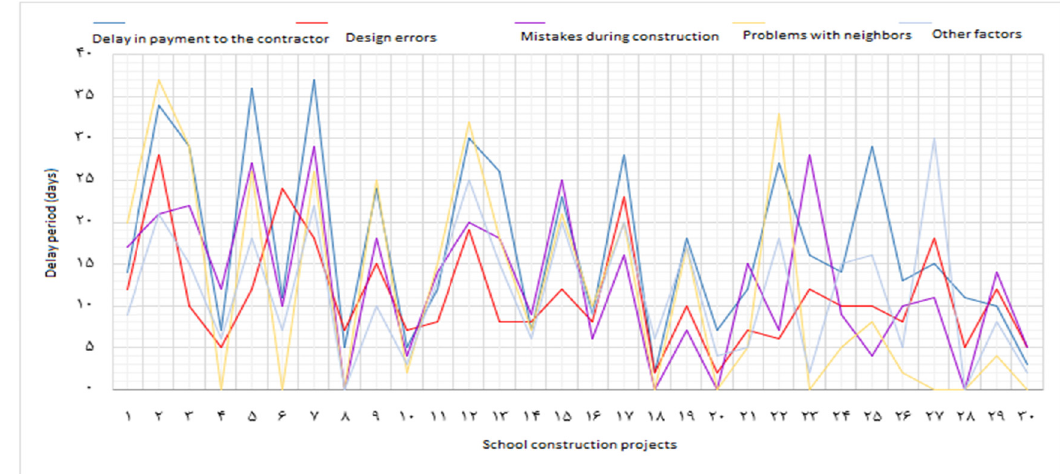
Figure 2: Comparison of the amount of delay caused by four factors with a line chart.